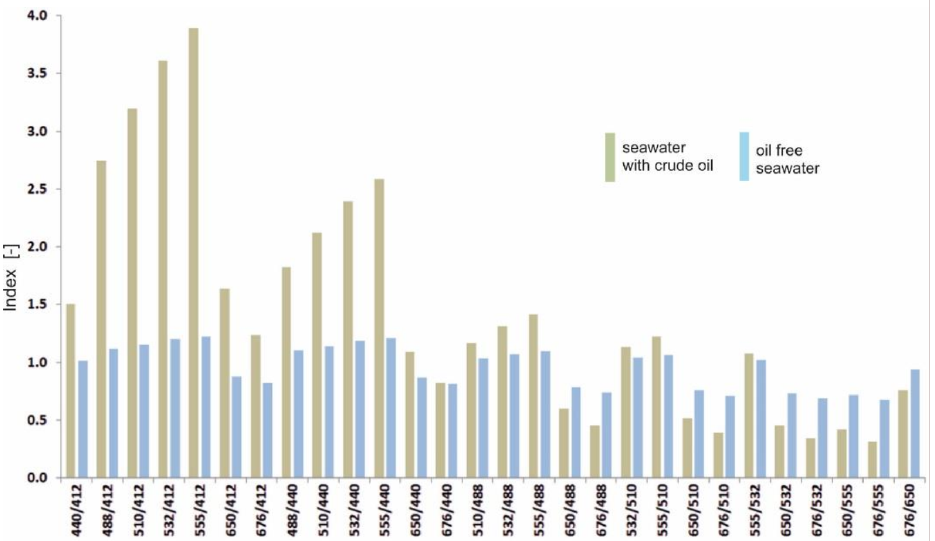
Figure 1. Spectral indices of the sea free of oil and in conditions of dispersed oil